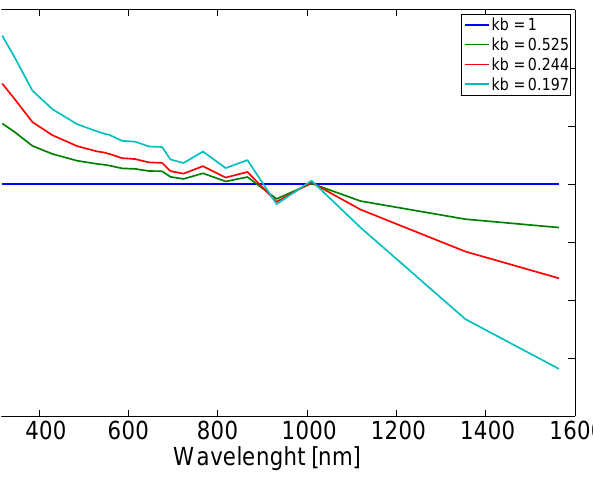
Figure 6. Conversion from the broadband cloud transmission described by the clear sky · k sat = f index k to a wavelength dependent transmission k . The corresponding bb (cid:3) (cid:3) bb conversion factor f is given for different cloud optical depths expressed by different broadband cloud transmissions k bb